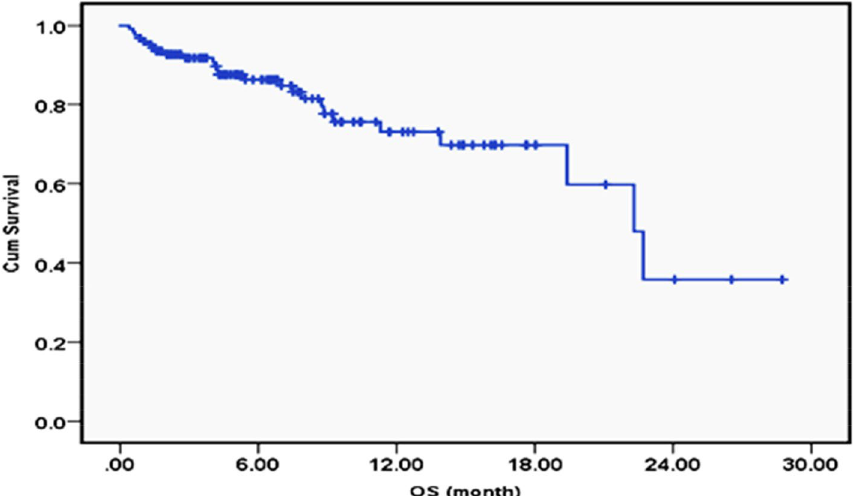
Fig. 1 Kaplan Meier plot of OS for all